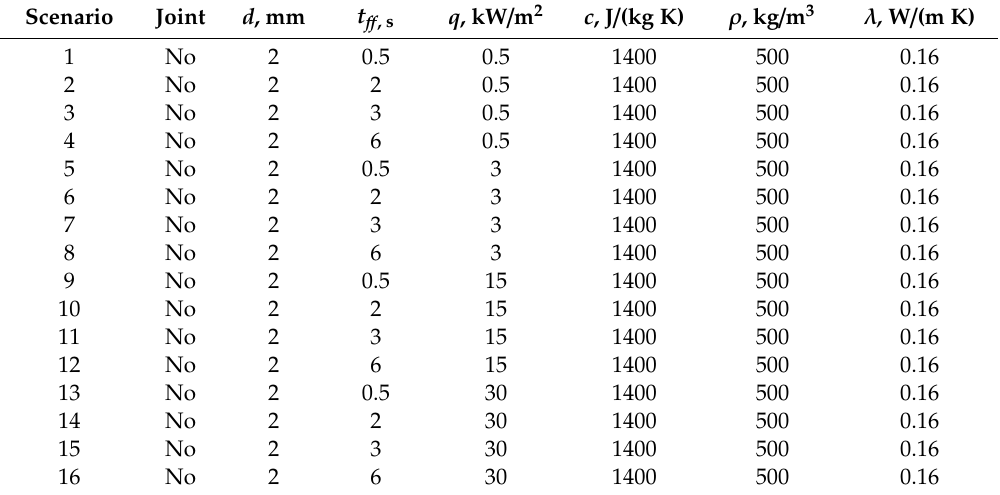
Table A1. The Main Scenarios of Forest Fire Impact on a Stem without a Joint. Part 1.